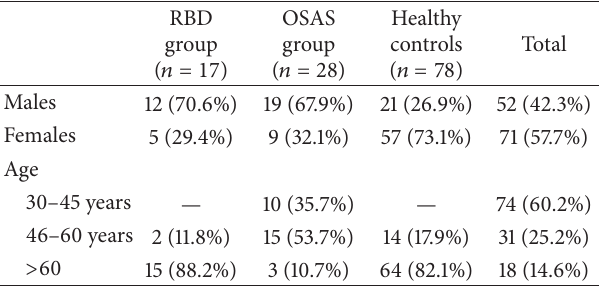
Table 1: Demographic characteristics of the